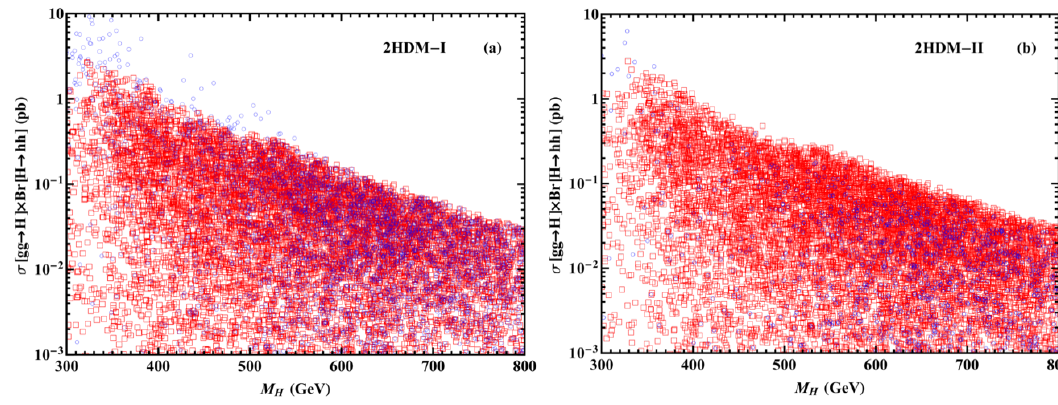
Figure 5 . (cid:27) ( gg ! H ) (cid:2) Br( H ! hh ) as a function of Higgs mass M for 2HDM-I in plot-(a) and for 2HDM-II in plot-(b). The blue points (circle shape) satisfy